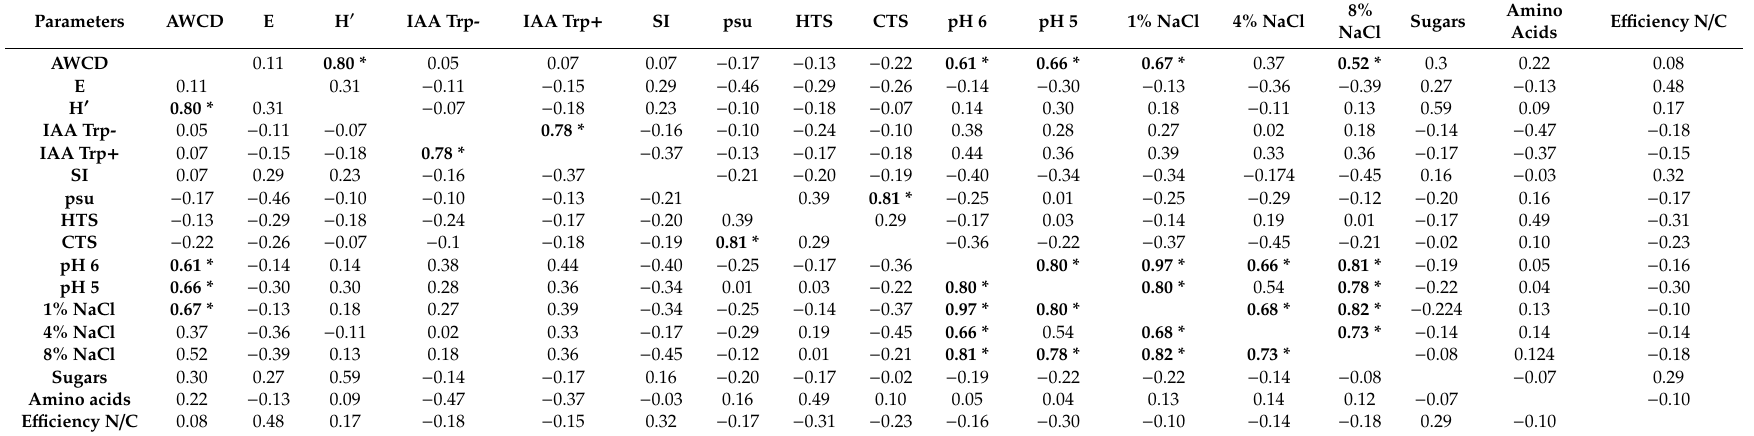
Table 4. Matrix correlation (Spearman correlation coe ffi cients with the Bonferroni correction) between the di ff erent variables of the tested endophytic